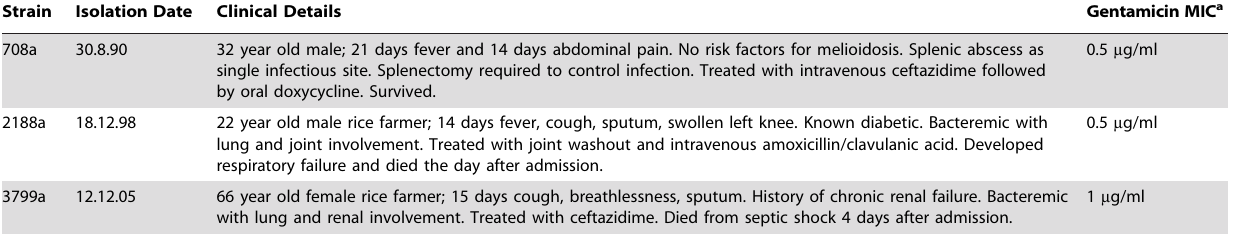
Table 2. B. pseudomallei strains: origins, properties and clinical